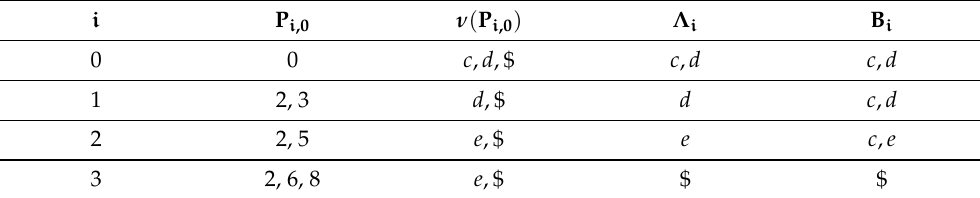
Table 5. The sets of states P i ,0 , the valid lookahead sets ν p P i ,0 q , and the sets Λ i and B i for the specifi- cation Ξ in